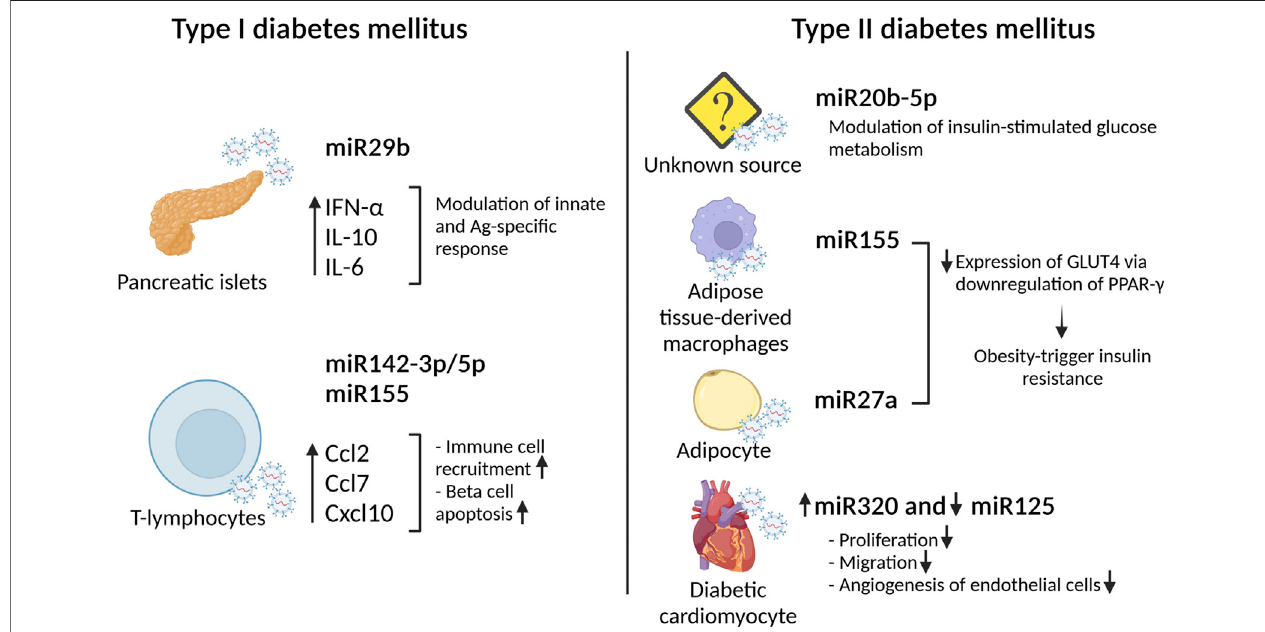
FIGURE1| SmallEVs miRNAeffect intype I and type IIdiabetes mellitus.Effects ofdifferentsmallEVs loadedwith speci fi cmiRNA in thedevelopmentofdiabetes.